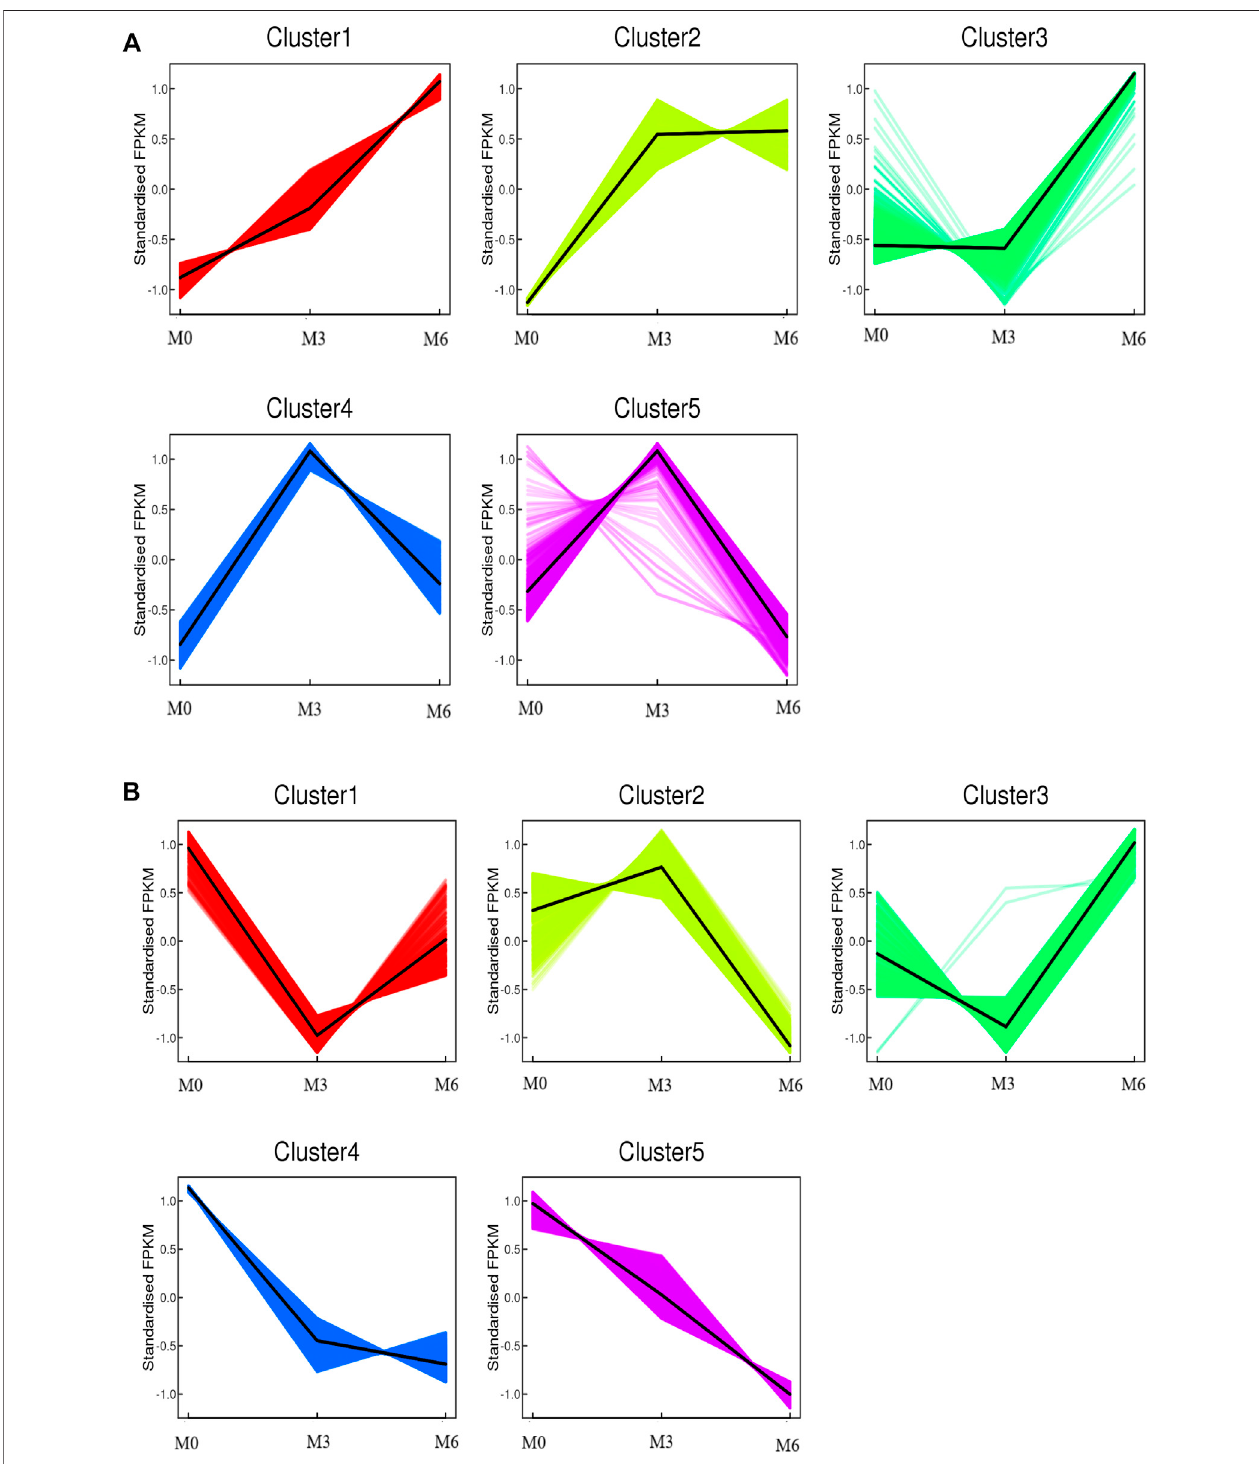
FIGURE 6 | Co-expression analysis of all genes obtained from different developmental stages. (A) Co-expression analysis of kmean_up based on three development stages (M0, M3, M6). (B) Co-expression analysis of kmean_down based on three development stages (M0, M3, M6).